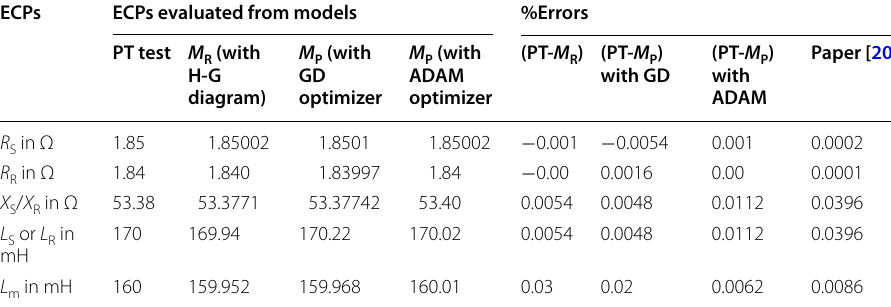
Table 1 ECPs evaluation using system models and physical tests ECPs ECPs evaluated from models %Errors